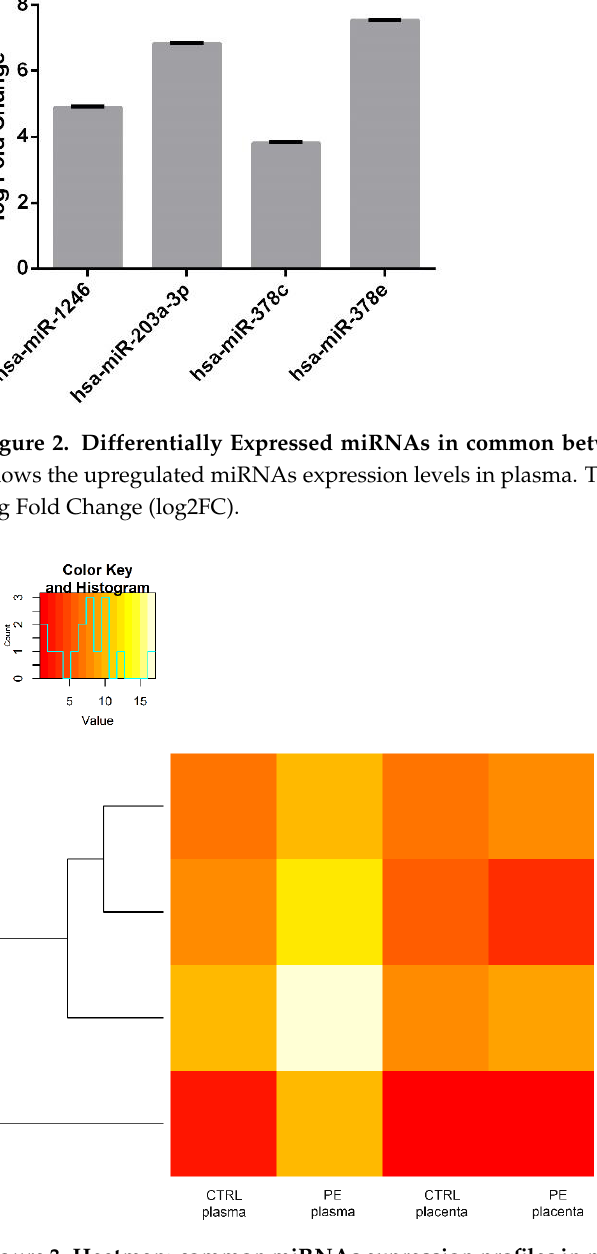
Figure 3. Heatmap: common miRNAs expression profiles in plasma and placenta . Heatmap shows the expression levels of each common miRNA in plasma and placenta tissues. The expression level of each miRNA (rows) was averaged within the pre-classified group (column). Values are expressed as log2CPM.